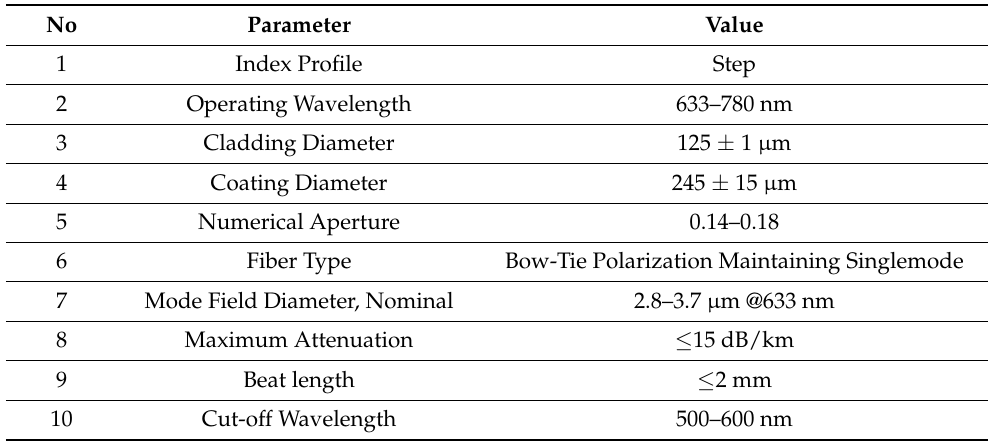
Table 1. Characteristics of F-SPV optical